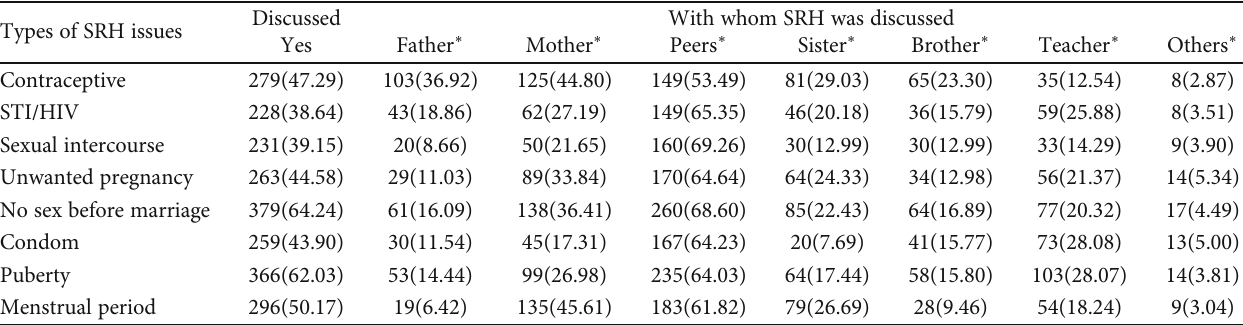
Table 2: Discussion on SRH issues among adolescents and their family and others in secondary and preparatory school students in Ambo Town, Oromia region, Ethiopia, 2019.